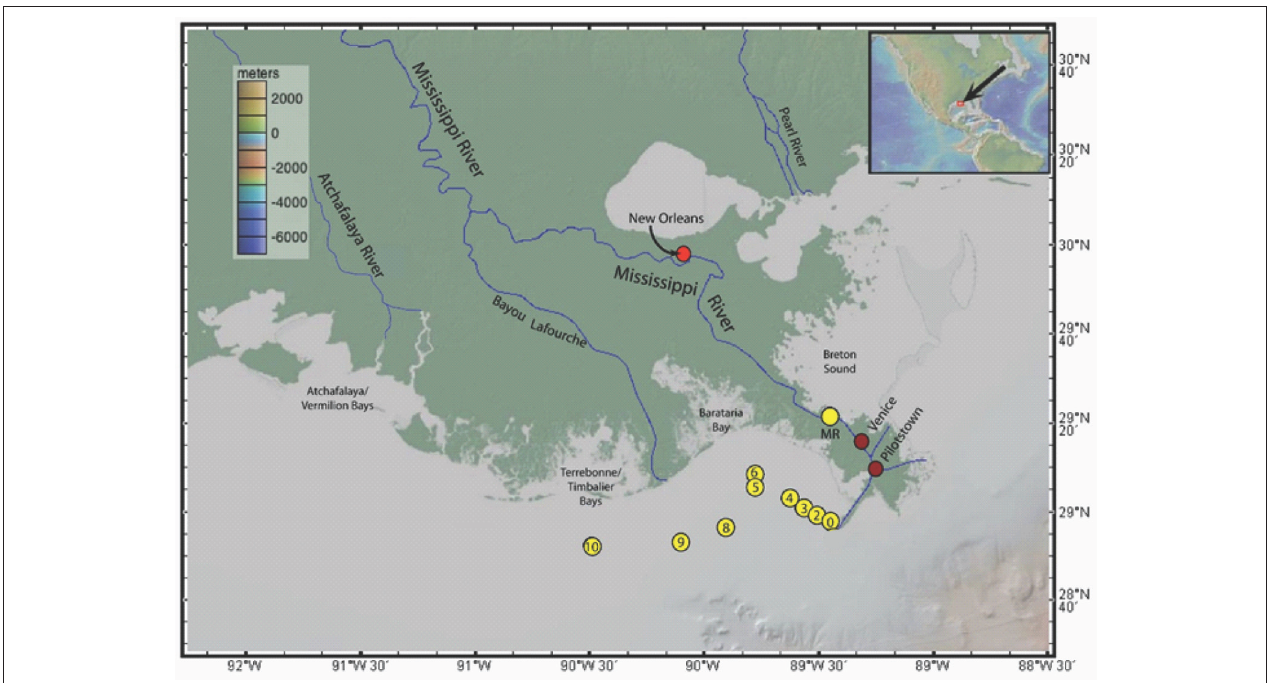
FIGURE 1 | Lower Mississippi River delta showing the sampling locations of waters (yellow circles), SPM (yellow circle labeled “MR”), and sediment (bright red circle labeled “New Orleans”). The dark red circles labeled “Venice” and “Pilotstown” show the locations of the earlier ε Nd(0) measurements by Stordal and Wasserburg (1986). Atchafalaya River and Bayou Lafourche are major and minor, respectively, distributaries of the MR. Base map from